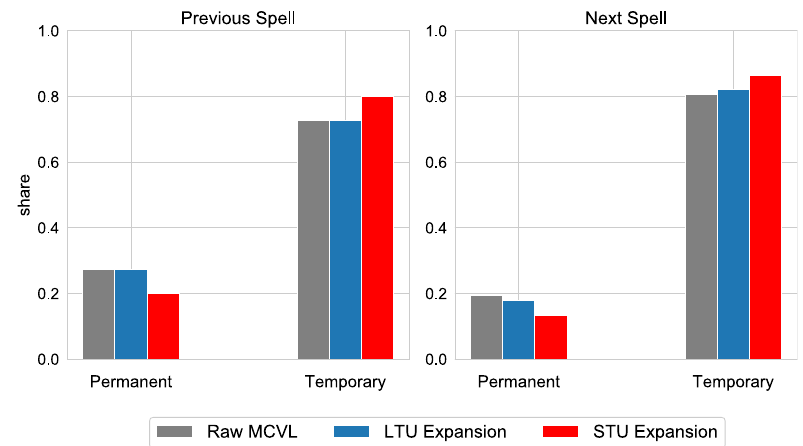
Fig. 6 Contract type before and after. All spells in the 2005–2013 period, by expansion. Source : MCVL